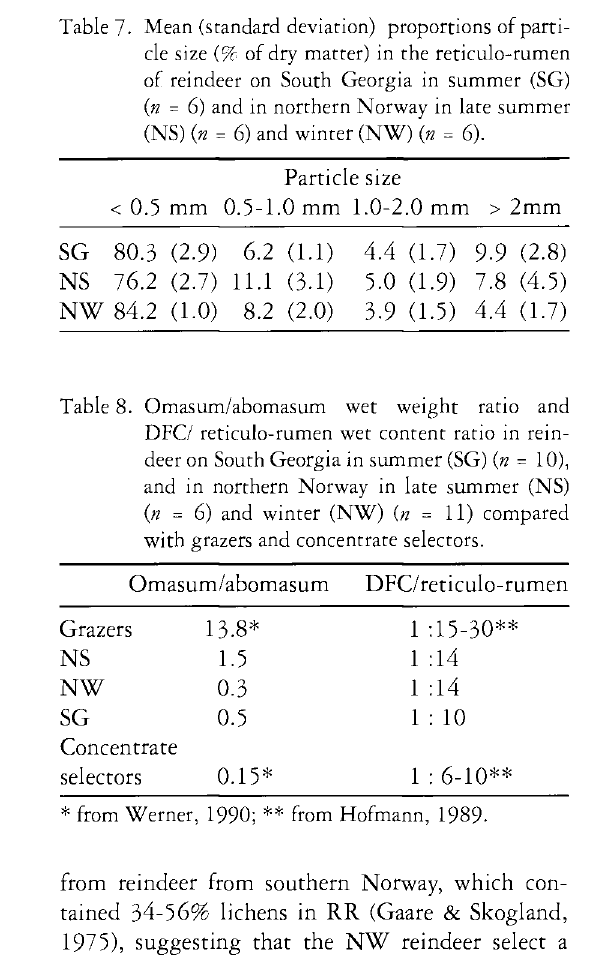
Table 7. Mean (standard deviation) proportions of parti cle size (% of dry matter) in the reticulo-rumen of reindeer on South Georgia in summer (SG) (» = 6) and in northern Norway in late summer (NS) (» = 6) and winter (NW) (» = 6).